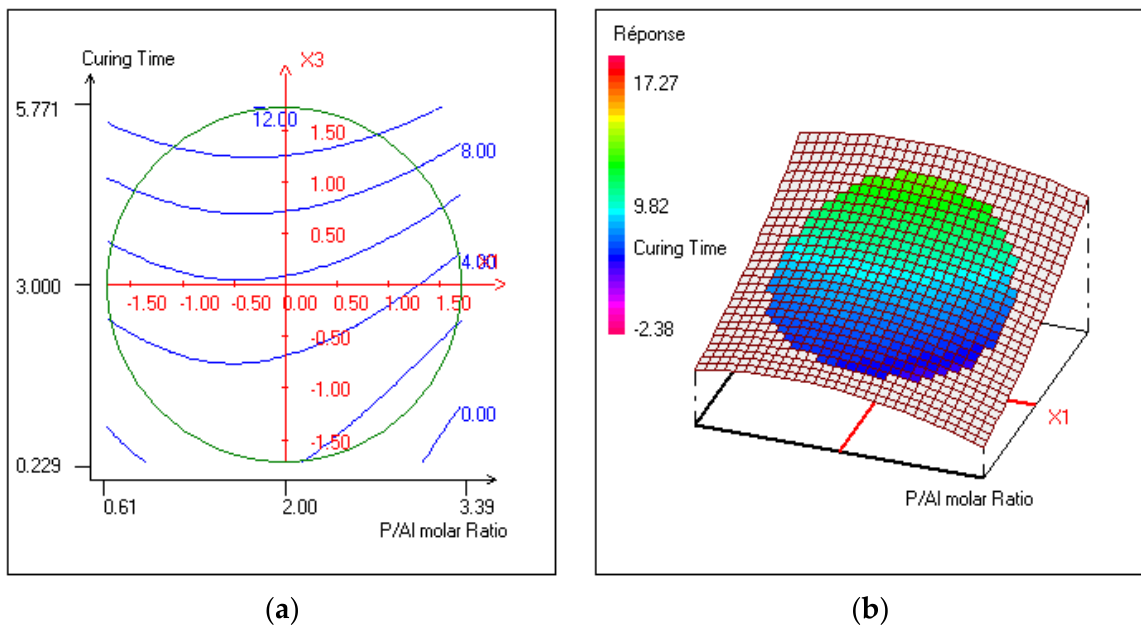
Figure 6. Variation in the response—released Al in the plan: P/Al molar ratio, curing time and fixed variable (curing temperature = 50.00 °C): ( a ) 2D contour plot; ( b ) 3D curve plot.